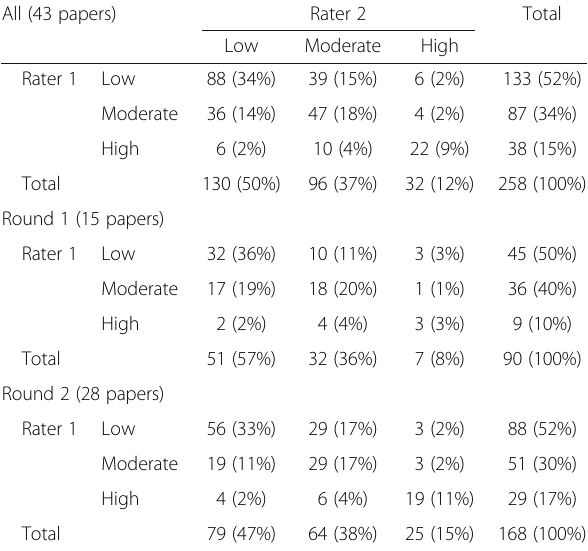
Table 1 Comparison of risk of bias judgment for all papers and for rounds 1 and 2